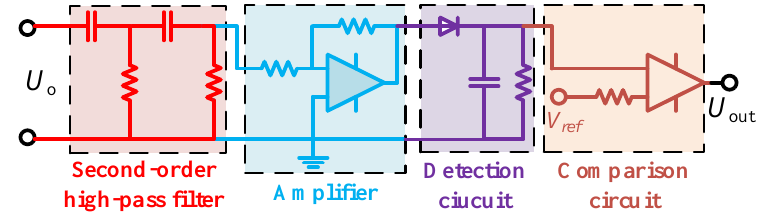
Figure 6. Demodulation circuit of the proposed SWPDT system.